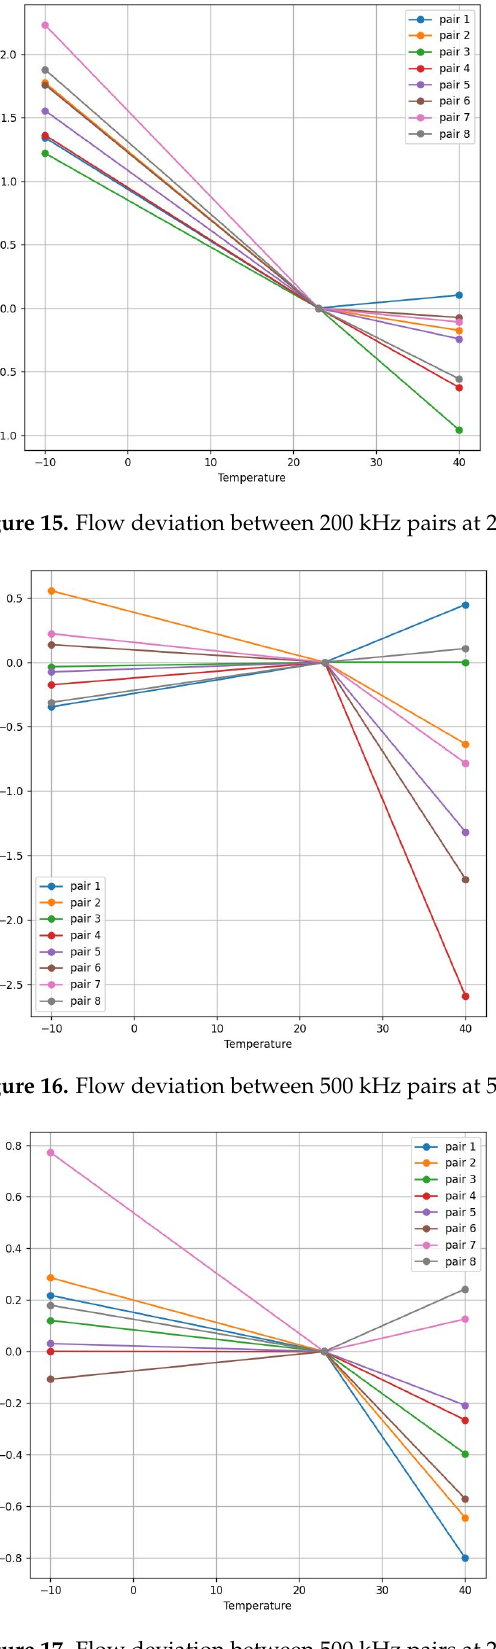
Figure 17. Flow deviation between 500 kHz pairs at 2000 L/h.